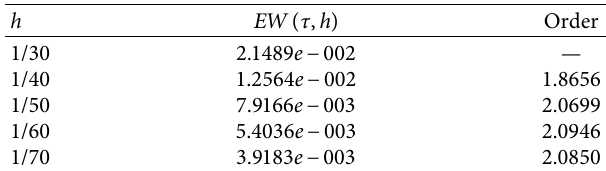
Table 2: Numerical convergence of scheme (50)–(59) in space